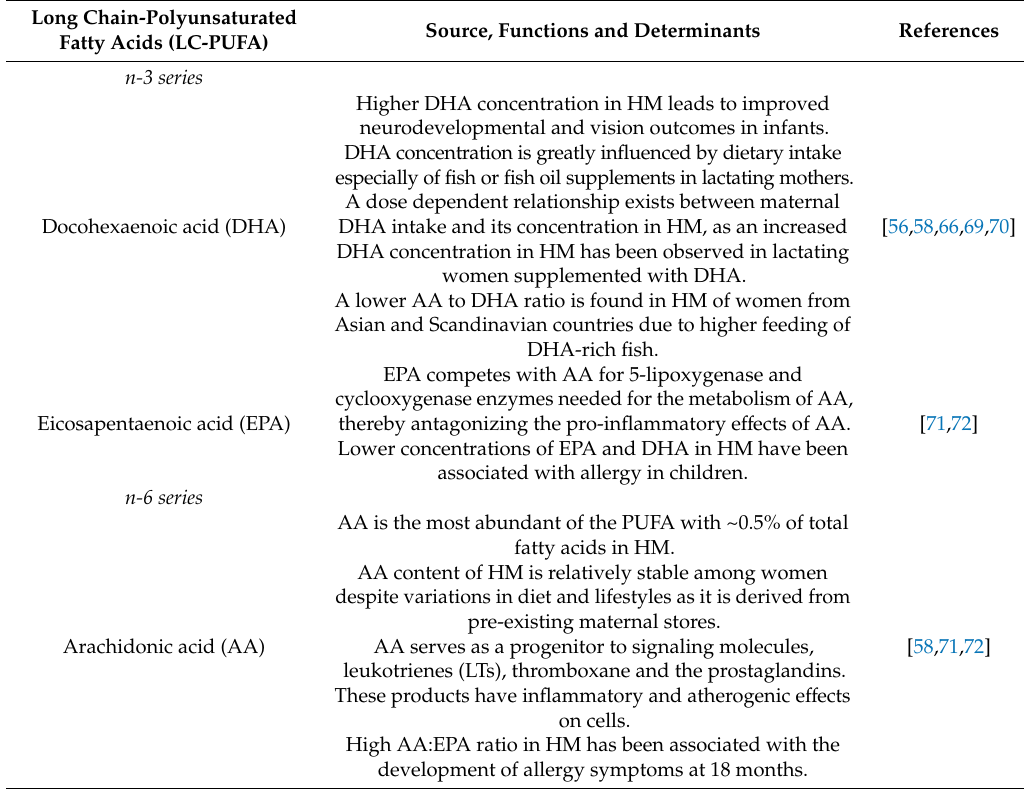
Table 2. Long chain-polyunsaturated fatty acids (LC-PUFA) in HM. Long Chain-Polyunsaturated Fatty Acids